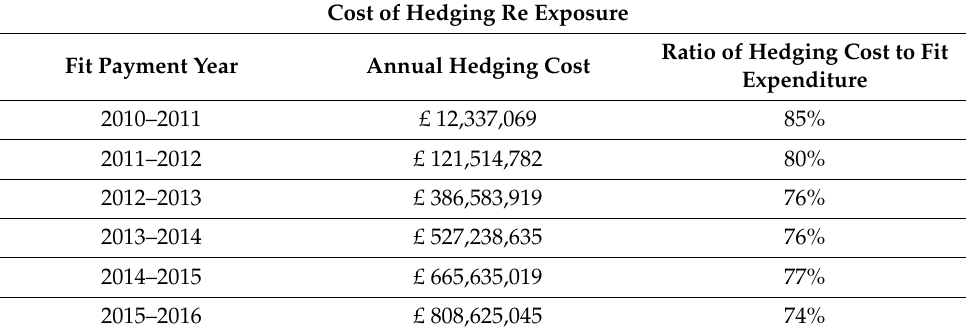
Table 5. Licensee hedging cost (source: author’s